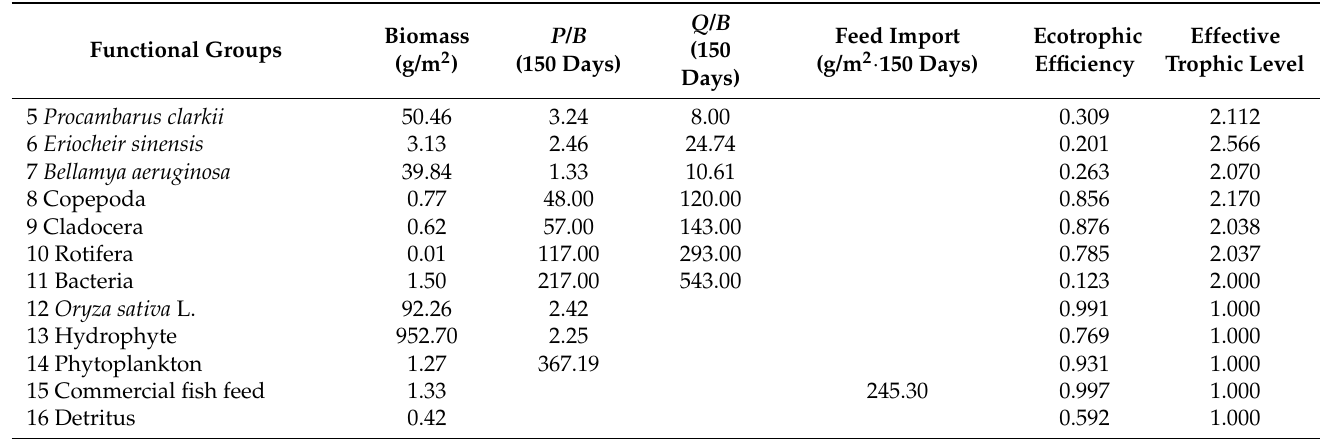
Table 2. Basic estimates of the Ecopath model.